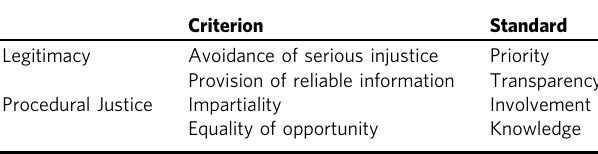
Table 1 Criteria and standards of legitimacy and procedural